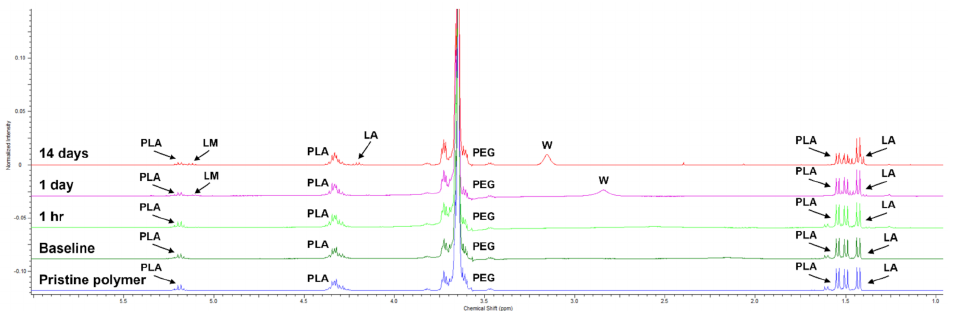
Figure 1. 1H-NMR spectra of pristine LEOL 400 after synthesis (pristine polymer), extracted from gamma-sterilized BCP-EP (baseline), and collected after immersion of BCP-EP in 0.01 M PBS at 37 ◦ C for 1 h, 1 day and 14 days. The characteristic chemical shifts are highlighted with reference to their compounds. LA: lactide; PLA: polylactide; LM: lactide monomer; W: water. Table 1. Molecular weight in Dalton (Da) and LA/PLA ratio of LEOL 400 after synthesis (pristine), extracted from gamma-sterilized BCP-EP (baseline), and collected after immersion of BCP-EP in 0.01M PBS at 37 ◦ C for 1 h, 1 day, and 14 days. Immersion Time